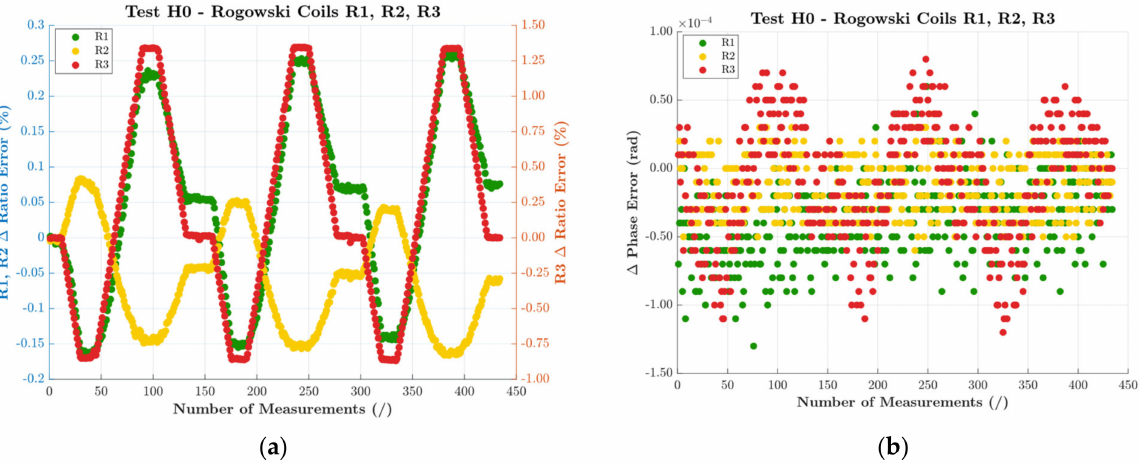
Figure 4. Results of the reference test performed with H0 and T1: ( a ) ratio error; ( b ) phase